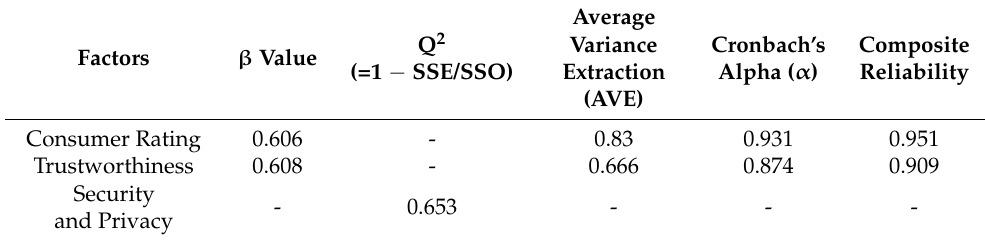
Table 5. Predictive relevance of model factors for